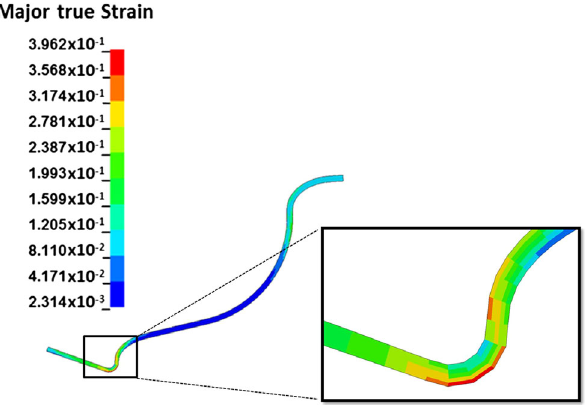
FIG. 7. Strain distribution through thickness after EHF of a niobium half-cell.